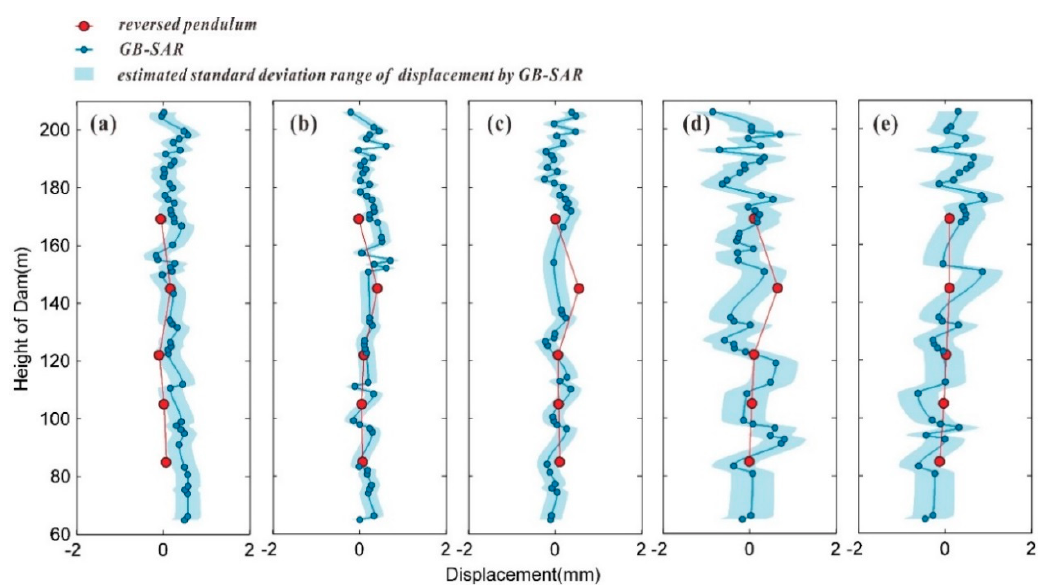
Figure 14. Comparison of monitoring results at central axis of dam surface by GB-SAR and reversed pendulum method for time intervals of ( a ) S1–S2, ( b ) S1–S3, ( c ) S1–S4, ( d ) S1–S5, and ( e ) S4–S5.